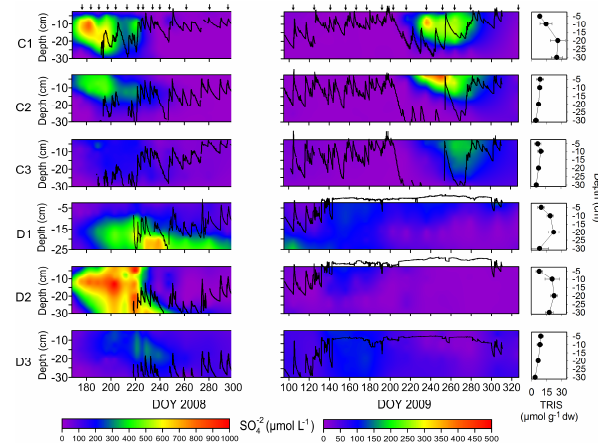
Fig. 7. Sulfate (SO 2 − ) concentrations. Refer to caption in Fig. 2. 4 The depth distribution of TRIS content in the solid phase is shown to emphasise the differences among plots, but it was not measured in this study (Table 1).